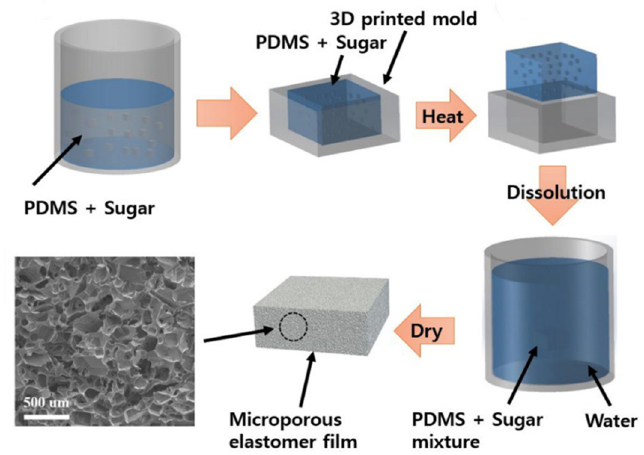
Figure 3. The typical fabrication process of the particle-template method. Reproduced with permission from [67] , Copyright (2017), Elsevier.